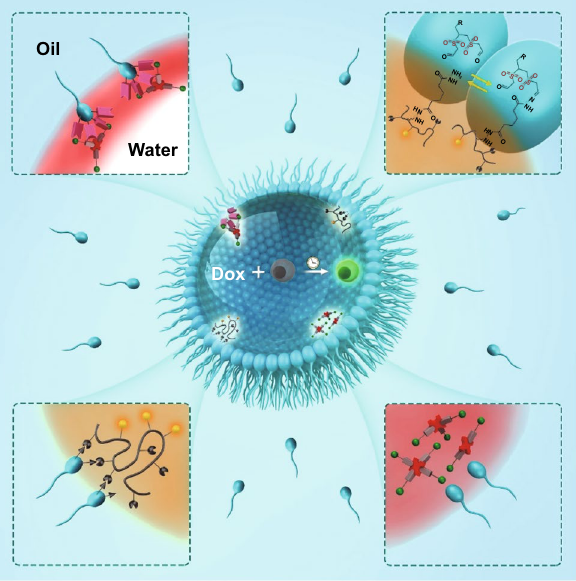
Fig. 2 Applications of functional surfactants Scheme showing adsorption of surfactant molecules at the interface of oil (turquoise background) and water (surrounded by surfactants) to stabilize water‑ in‑oil drop. The spherical part of the surfactant represents the polar head that meets water, while the wavy line represents the nonpolar tail that stays in the oil (turquoise background). At the center of the drop, it shows co‑encapsulation of Doxorubicin (Dox) and a cell that yields a fluorescent cell. The top left inset shows the interaction of azide‑bearing surfactant 4 with encapsulated proteins. The bottom left inset shows the interaction of aldehyde‑bearing surfactant 5 with encapsulated polymer. The bottom right inset shows no interaction of non‑functional surfactant 3 with the encapsulated proteins. An exem‑ plary reversible chemical reaction is shown between aldehyde‑bear‑ ing surfactant 5 and hydrazide‑bearing polymer labeled with a fluo‑ rescent dye which is encapsulated into the drop (the top right inset, which corresponds to the bottom left